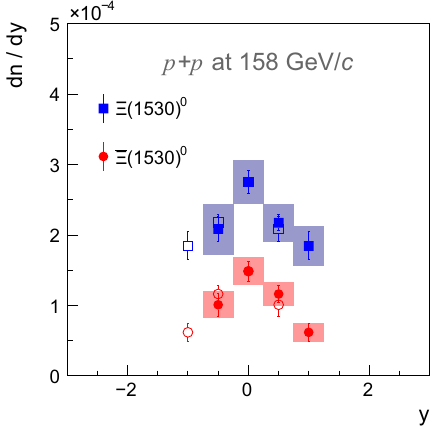
Fig. 8 Rapidity spectra of (cid:2)( 1530 ) 0 (blue squares) and (cid:2)( 1530 ) 0 (red circles) produced in inelastic p+p interactions at 158 GeV / c . Sta- tistical uncertainties are shown by vertical bars, and shaded bands cor- respond to systematic uncertainties of the measurements. Full sym- bols show measured points, open symbols values reflected around mid- rapidity